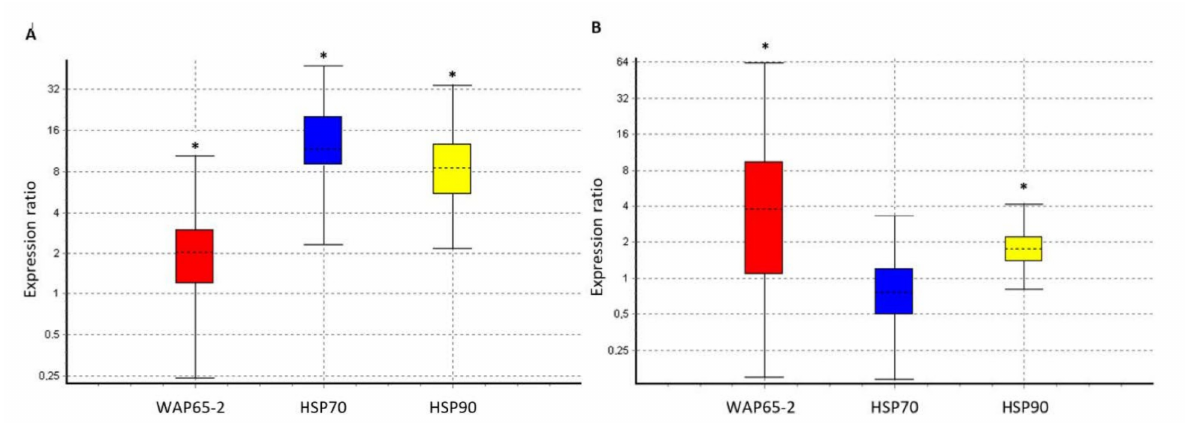
Figure 2. Relative expression of WAP65-2, HSP70, and HSP90 genes in liver ( A ) and kidney ( B) of the wild-caught, compared to the farmed, turbot Scophthalmus maximus. Ct values obtained by quantitative real time PCR were analyzed with REST 2008. Data are presented relative to farmed turbot (expression set as 1) as whisker–box plots in order to see expression median and distribution of permutated expression values with 95% confidence level. Therefore, the expression ratio values of >1 denote higher fold-change in wild-caught than in farmed turbot and values of <1 denote lower fold-change in wild-caught than in farmed turbot. Significant changes are marked as * p <